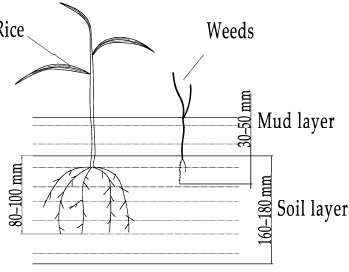
Figure 7. Diagram of water field environment.